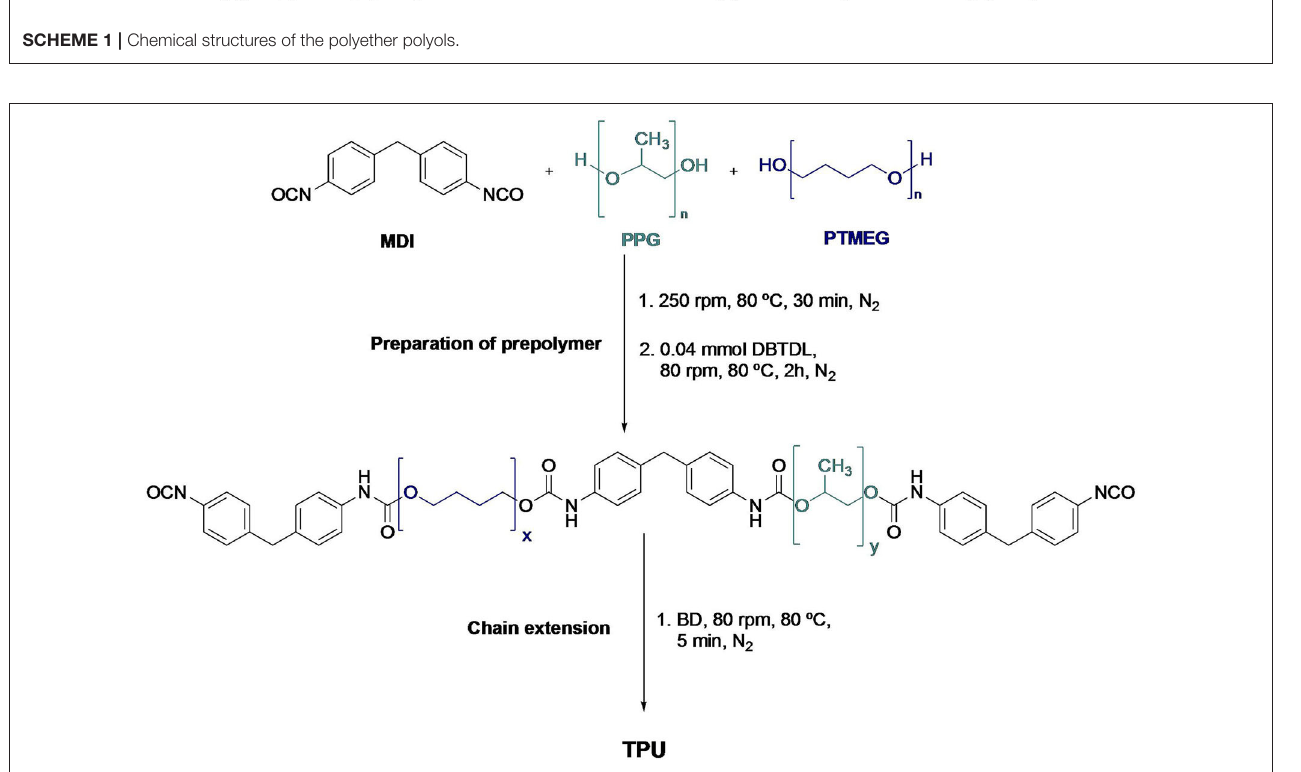
FIGURE 1 | Scheme of the synthesis of the thermoplastic